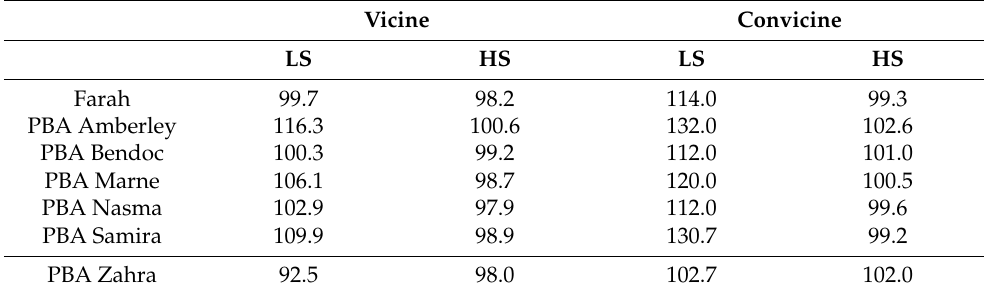
Table 5. Post extraction spikes to determine matrix effect.